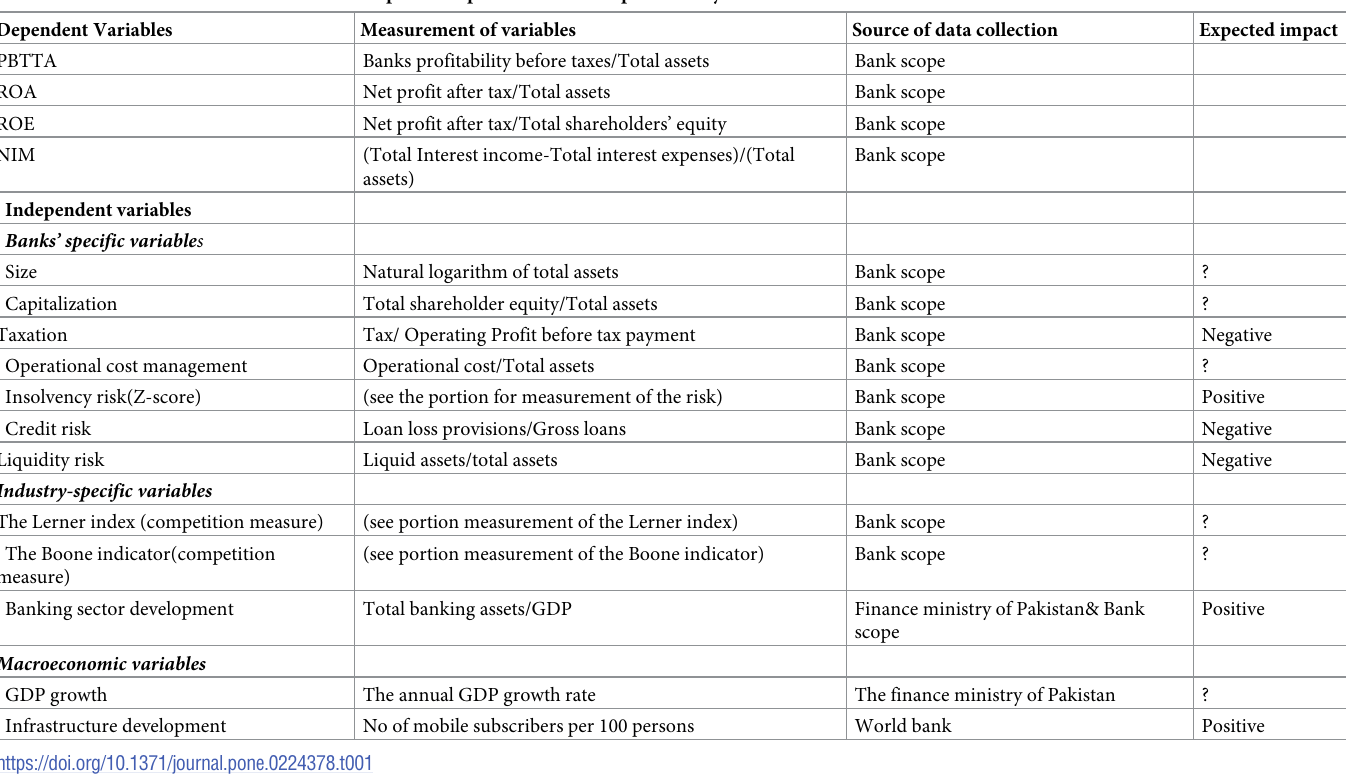
Table 1. Measurement of variables and their expected impact on the banks’